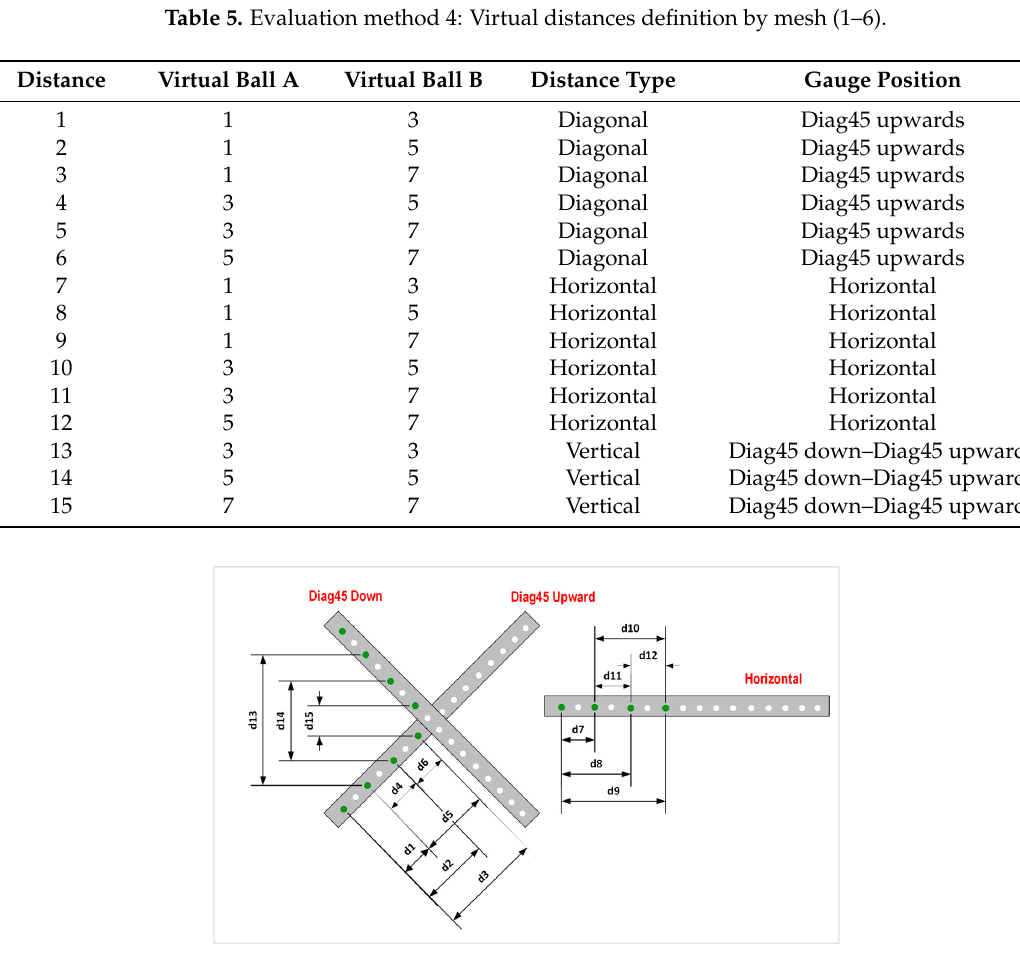
Figure 9. Evaluation method 4: virtual vertical, horizontal and diagonal distances in virtual mesh 1.